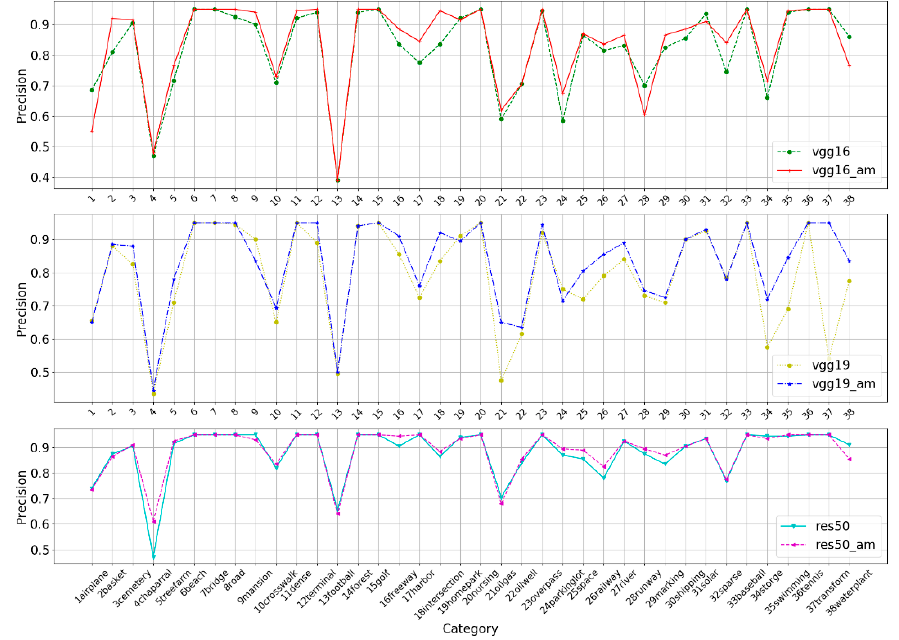
Figure 8. Class-level precisions of different baseline networks and the corresponding average pooled attention modules, where vgg16_am means the vgg16 combined with the average pooled attention module.